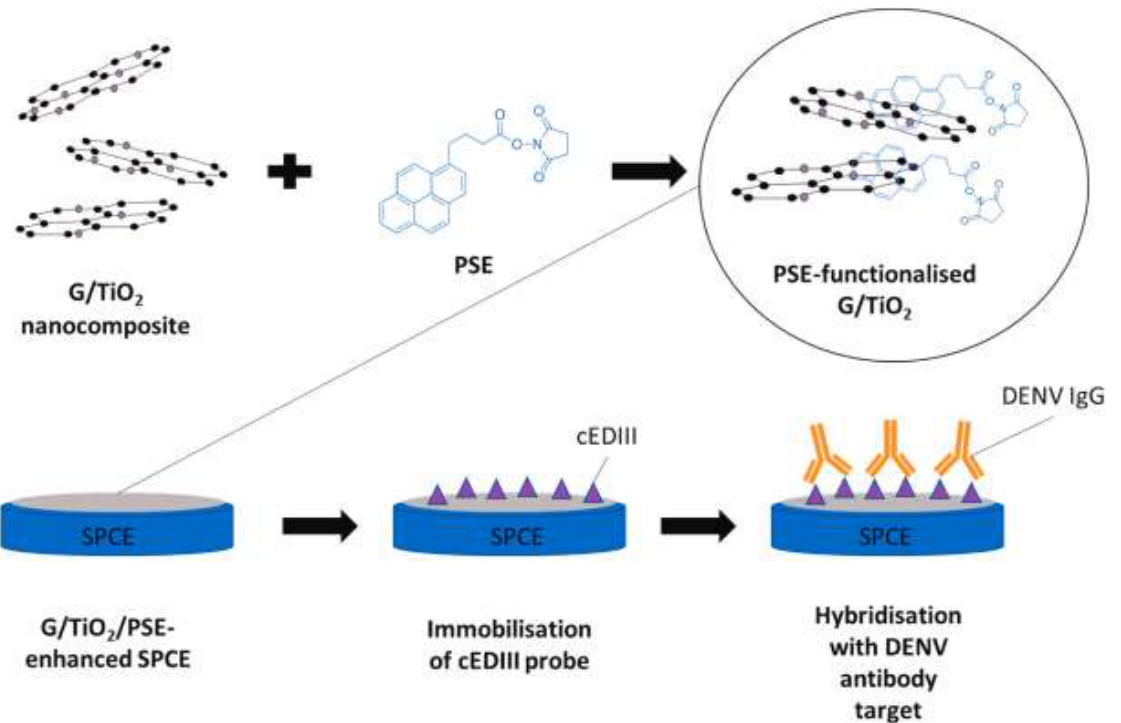
Figure 8. Schematic diagram for the development of G/TiO 2 /PSE-modified electrochemical im- munosensor for dengue detection (Reprinted with permission from Ref. [87]. Copyright 2021, Else- vier).